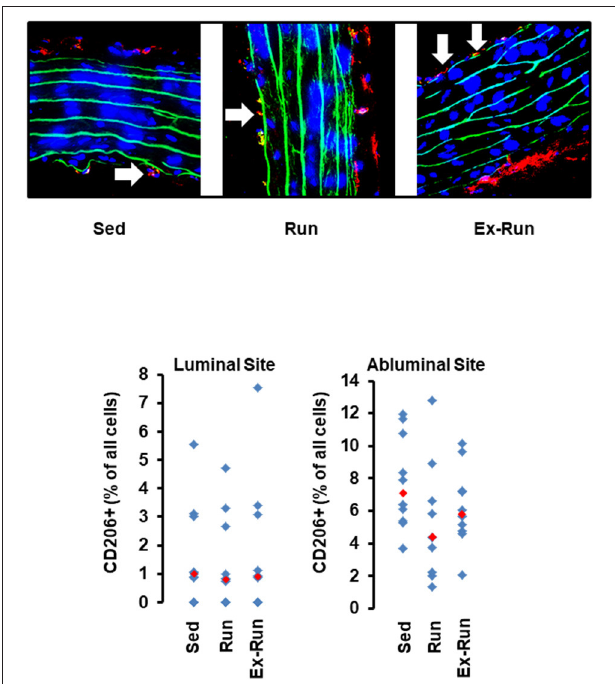
FIGURE 5 | Histological cross sections from aortae of hypertensive rats and the effect of voluntary running wheel activity. Top: Representative slights from confocal laser microscopy used to count the number of CD206 + cells (in red) normalized to the total cell number as calculated by DAPI-stained nuclei in blue. Lamina elastica is seen in green. Bottom: Quantification of different slices from n = 5 rats each group. Red rectangles indicate the median, blue rectangles individual data points.